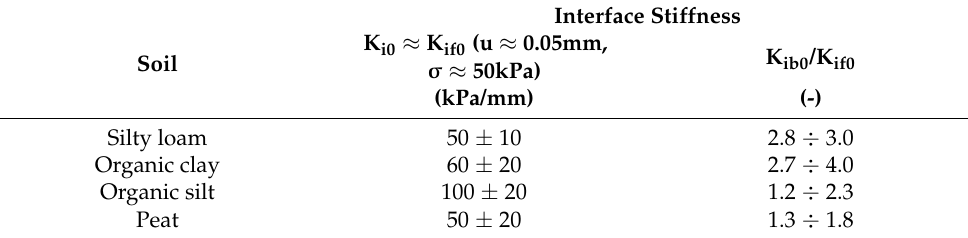
Figure 9. Stress dependency of interface shear stiffness: ( a ) smooth interface, ( b ) rough interface. Table 7. Interface stiffness characteristics for smooth concrete–soil interfaces.